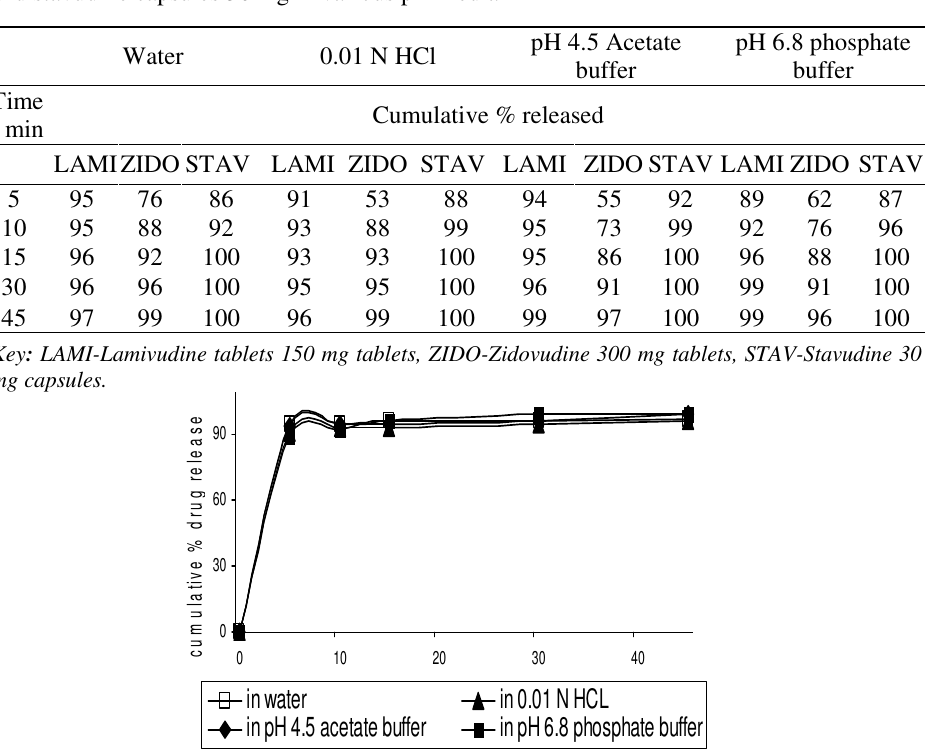
Table 2 . In-vitro dissolution rate of lamivudine tablets 150 mg, zidovudine tablets 300 mg and stavudine capsules 30 mg in various pH media